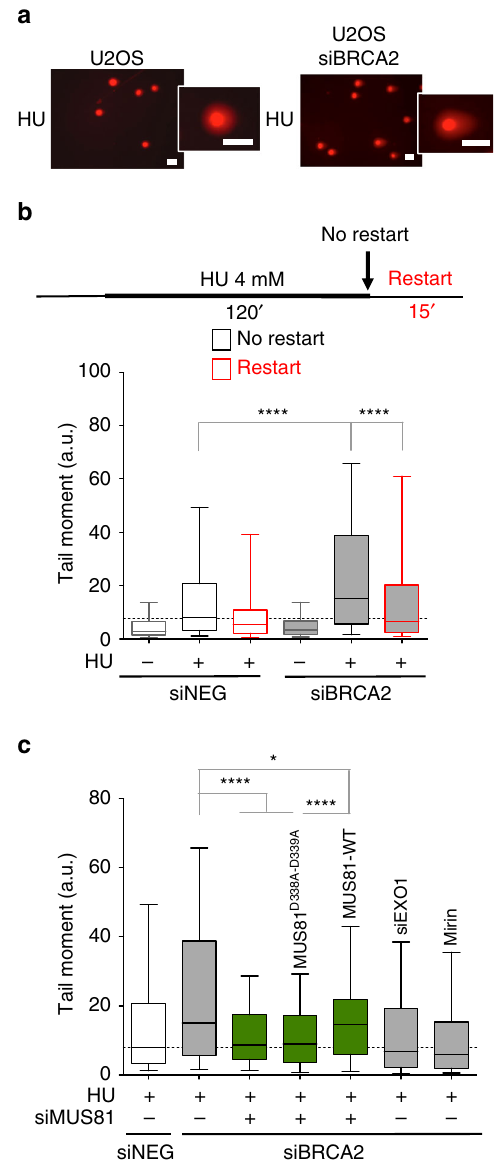
Fig. 4 MUS81 cleavage leads to transient DSB accumulation in BRCA2- de fi cient cells. a Representative comet images of BRCA2-pro fi cient and -de fi cient cells following treatment with 4 mM HU for 120 min. Scale bar, 50 μ m. b Neutral Comet assay monitoring DSB formation in BRCA2- de fi cient and -pro fi cient U2OS cells following HU treatment for 120 min (no restart) and 15 min after HU removal (restart). Cells were transfected with control siRNA (siNEG) or BRCA2 siRNA. Out of 3 repeats; n ≥ 200 comets scored for each data set. Whiskers the 10th and 90th percentiles. **** P <